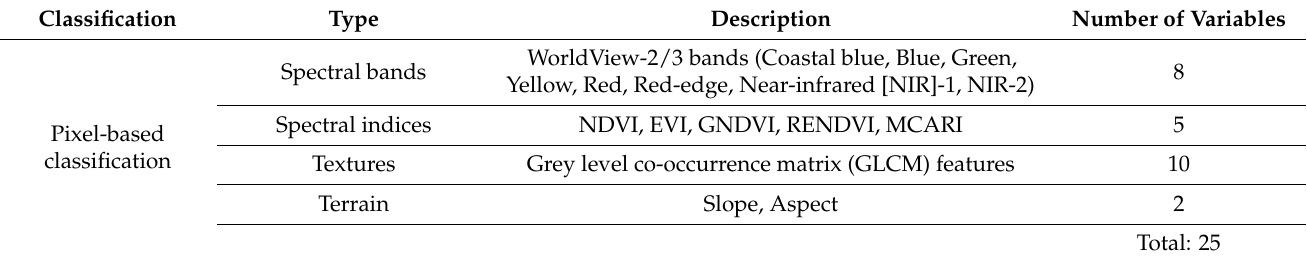
Table 5. List of variables used in pixel- and object-based